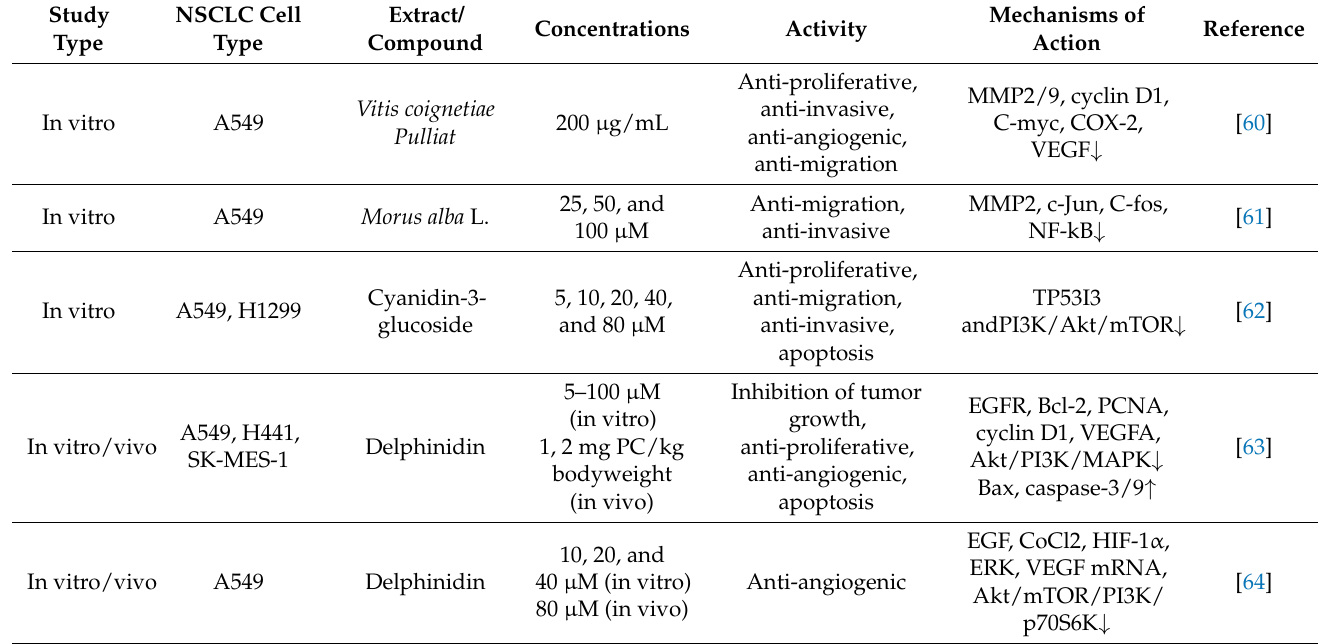
Table 2. The molecular mechanisms of ACNs in nicotine-induced NSCLC